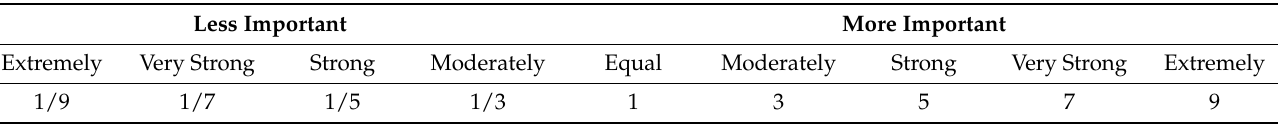
Table 4. A Nine-point continuous comparison